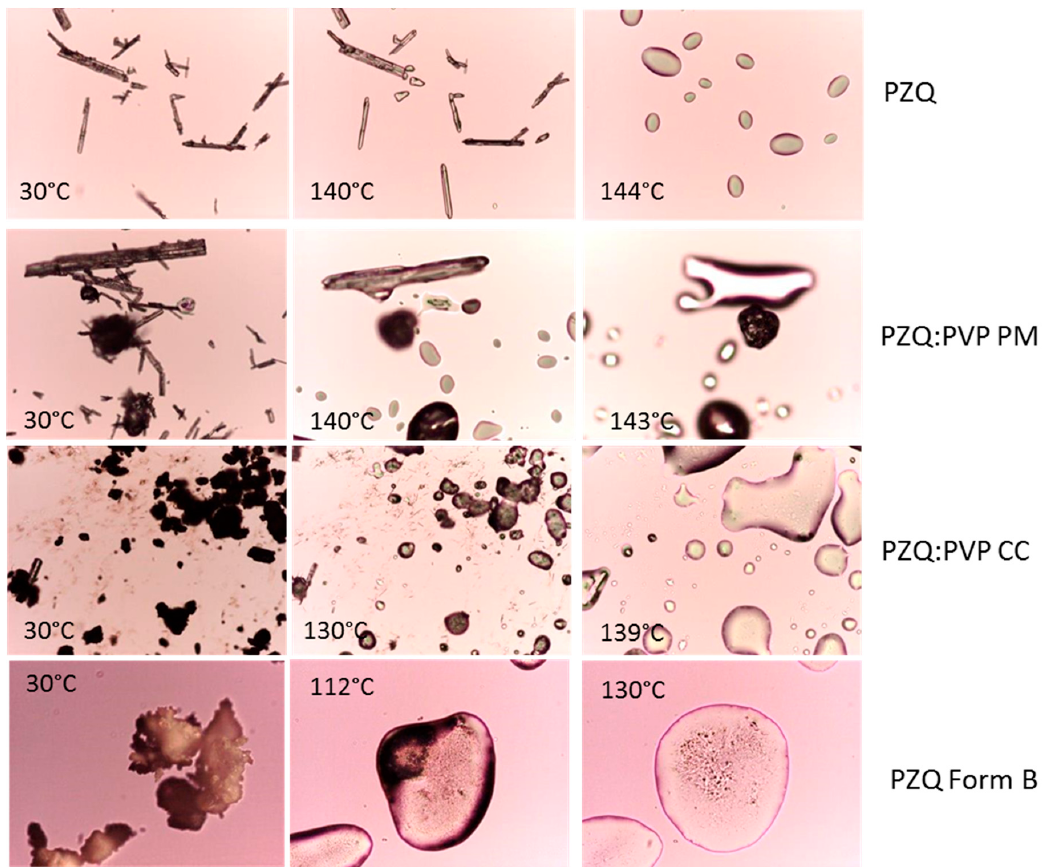
Figure 3. Hot Stage Microscopy (HSM) analysis of raw PZQ, PVP K30, physical mixture, and activated materials (magnification 10×).